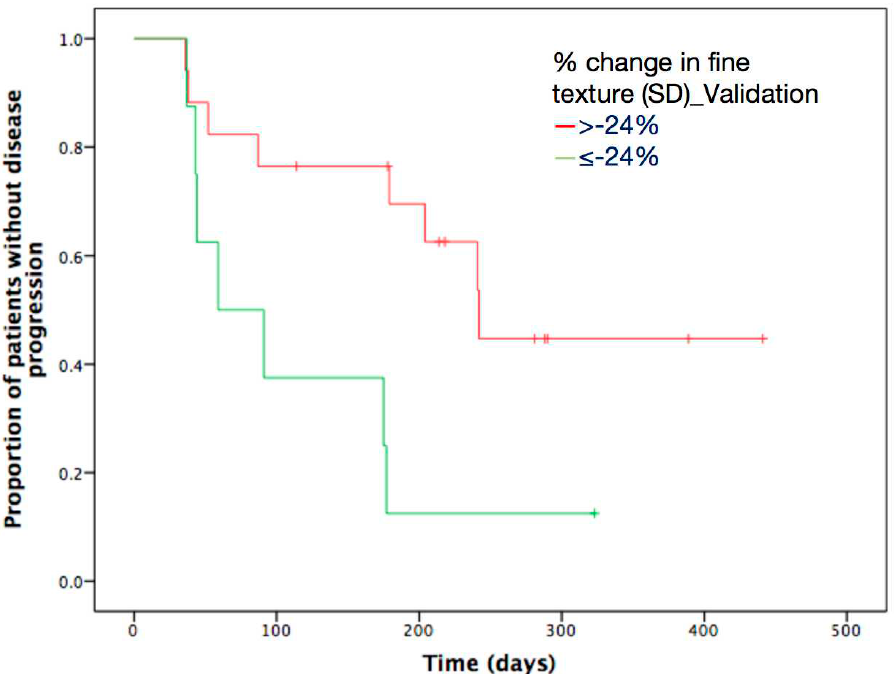
Figure 3. Kaplan-Meier survival curves according to percentage change in SD at fine (SSF2) texture scale in validation cohorts. Patients with percentage change in SD below optimal thresholds of − 0.24 at fine texture scales showed significantly poorer survival in validation cohorts. TTP = time to progression.